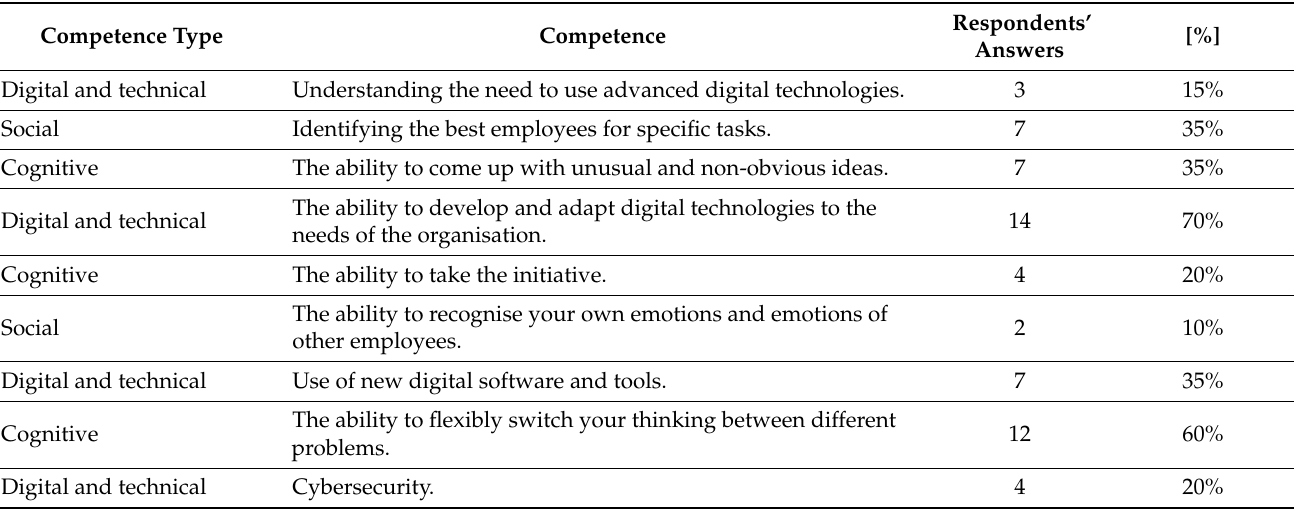
Table 5. Analysis of key competences.